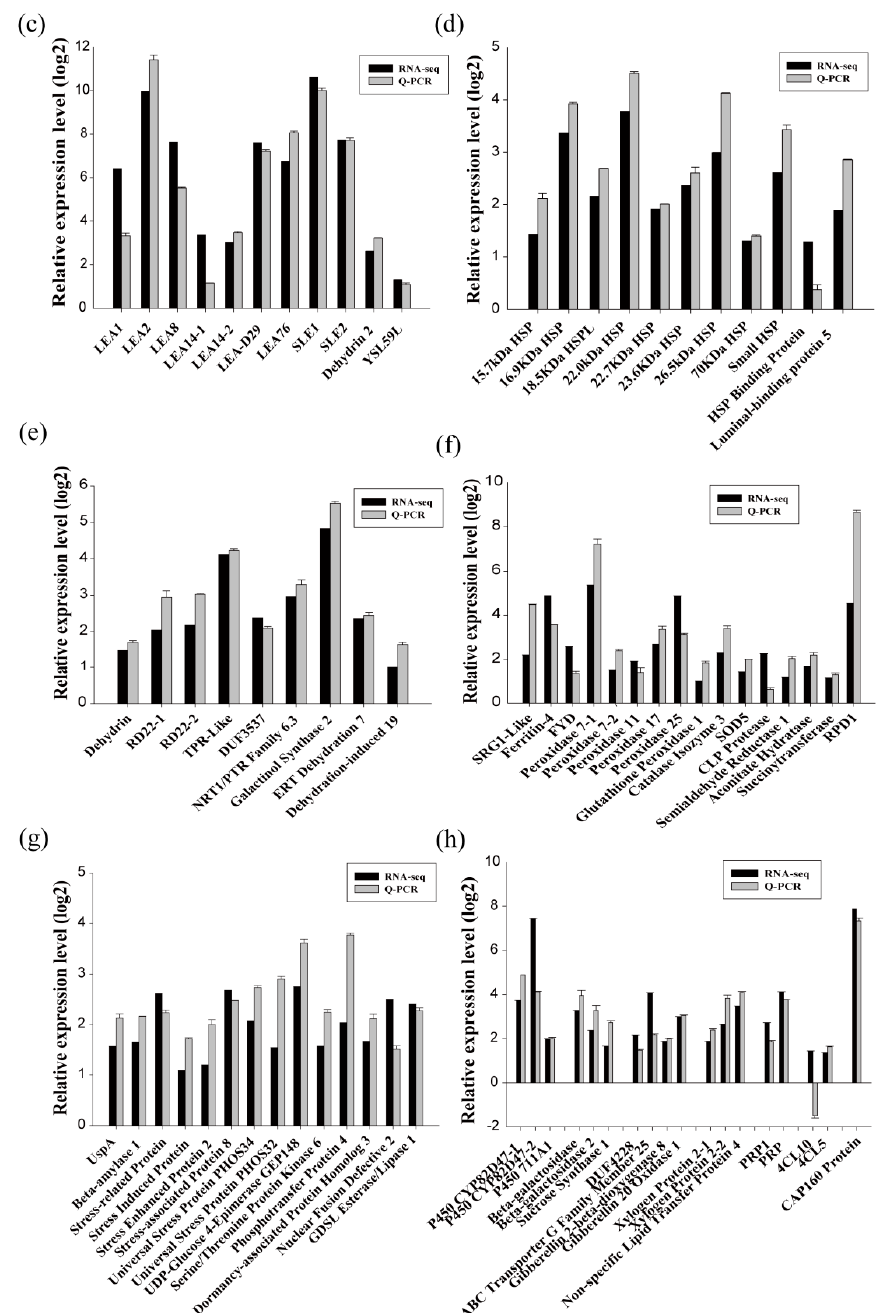
Figure 2. Quantitative RT-PCR confirmation of the differentially expressed genes identified using RNA-Seq. ( a ) The families of differentially expressed transcription factors in birch under drought stress conditions. ( b – h ) Comparison of the expression level of differentially expressed genes in the function involved in: transcription factors ( b ), late embryogenesis abundant proteins ( c ), heat shock proteins ( d ), ROS-scavenging-related proteins ( e ), water deprivation-related proteins ( f ), stress-related proteins ( g ), and others ( h ) between qRT-PCR and RNA-Seq.